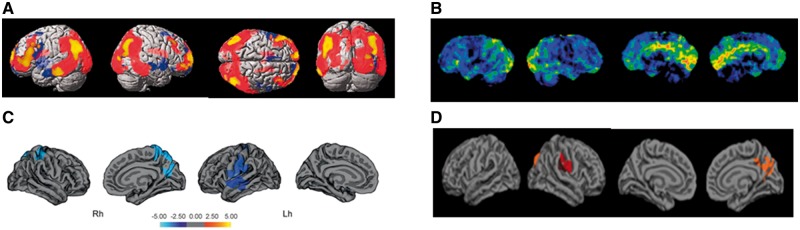

Cerebral hypometabolism and dementia in Parkinson’s disease and grey matter atrophy in Parkinson’s with cognitive involvement. (A) Regions of cerebral hypometabolism in patients with PDD overlap with regional atrophy. Adapted from González-Redondo et al. (2014). (B) Statistical maps of baseline 18F-FDG-PET data comparing patients with Parkinson’s disease that later develop dementia with controls. Hypometabolism is seen in posterior brain regions particularly in cuneus and precuneus. Image adapted from Bohnen et al. (2011). (C and D) Vertex-wise comparisons of cortical thickness between patients with PD-MCI and Parkinson’s disease without cognitive involvement. Atrophy patterns differ between studies, although atrophy in the precuneus is frequently reported. (C) Greatest atrophy seen in left precuneus. Modified with permission from Pereira et al. (2014). (D) Greatest atrophy seen in precuneus and bilaterally in superior parietal regions. Figure adapted from Segura et al. (2014). Lh = left hemisphere; Rh = right hemisphere.